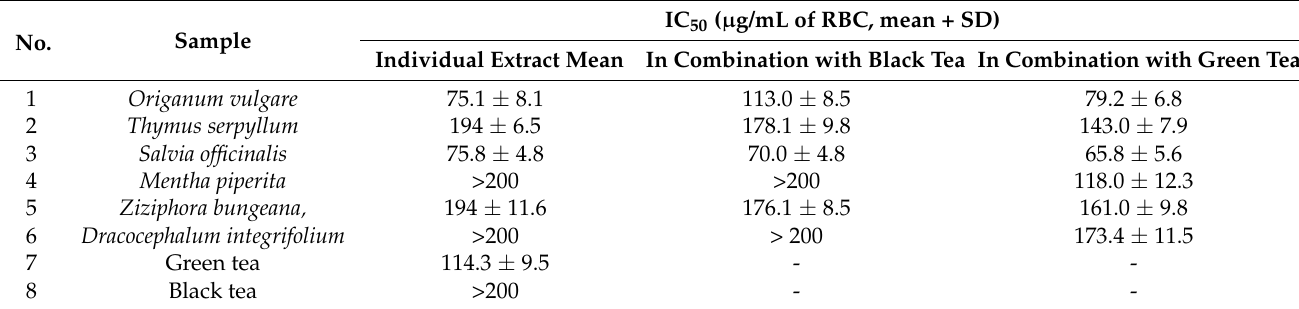
Table 5. Membrane-stabilizing properties of combination extracts of plants and tea (mean +